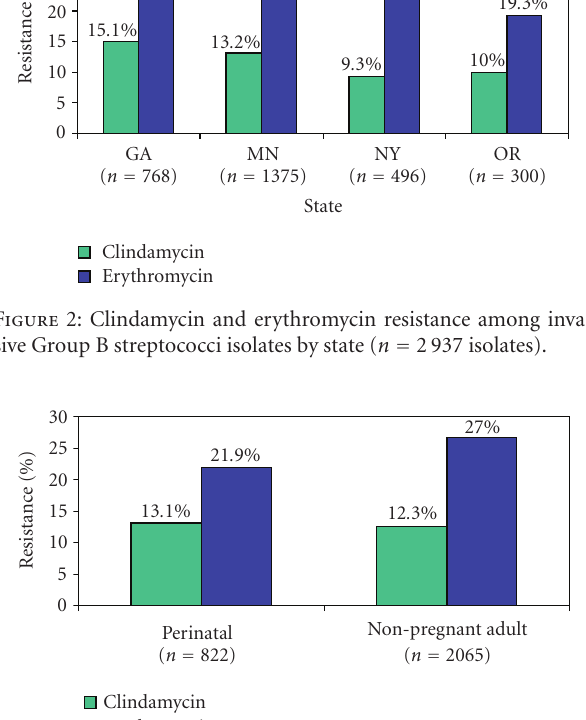
Perinatal ( n = 822)